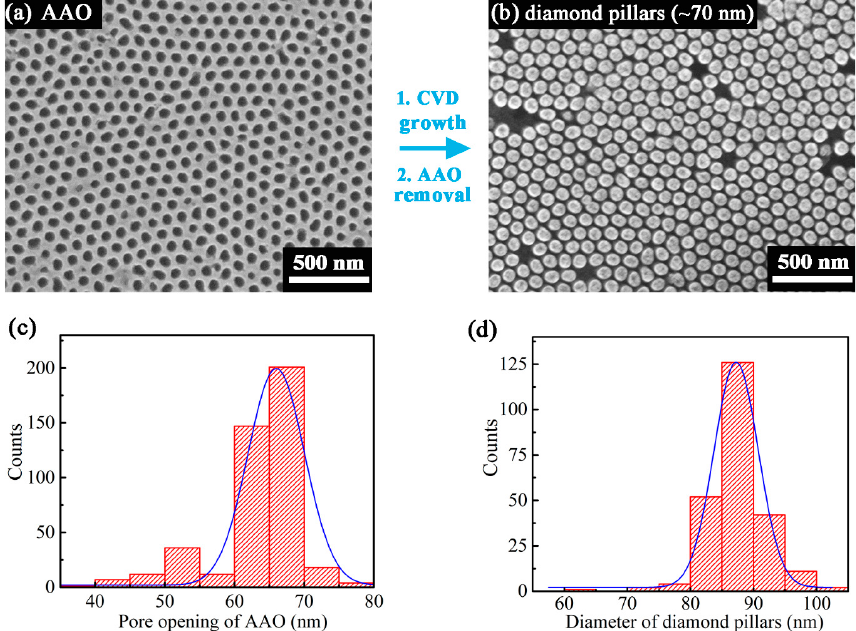
Figure 4. Characterization of AAO membrane and as-grown diamond pillars with nominal diameter of ~70 nm. SEM images of ( a ) AAO membrane and ( b ) released diamond pillars. Frequency distribution histograms of ( c ) AAO nanopores and ( d ) diamond nanopillars.